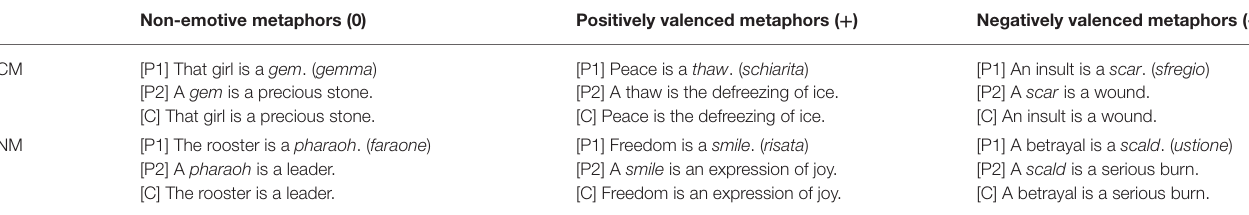
TABLE 1 | Examples of arguments in English for each middle term condition (Experiment